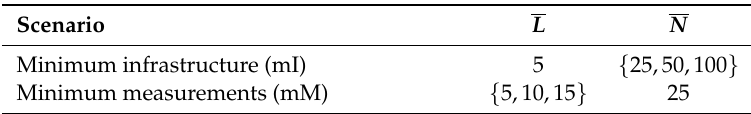
Table 3. ANs/RNs optimized